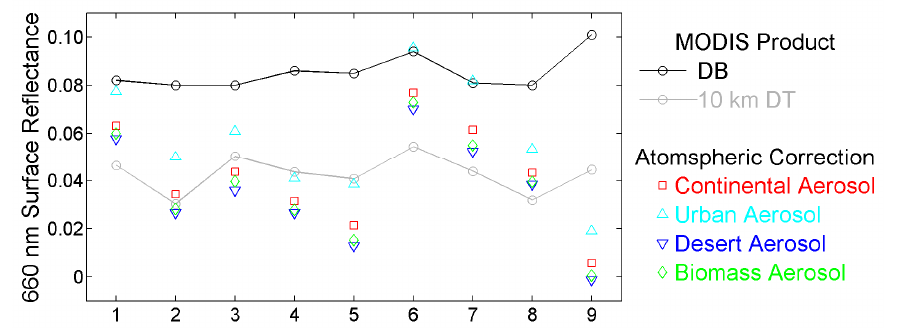
Figure 4. Comparisons between the 660 nm surface reflectance from MODIS products and atmospheric corrections using different aerosol types.